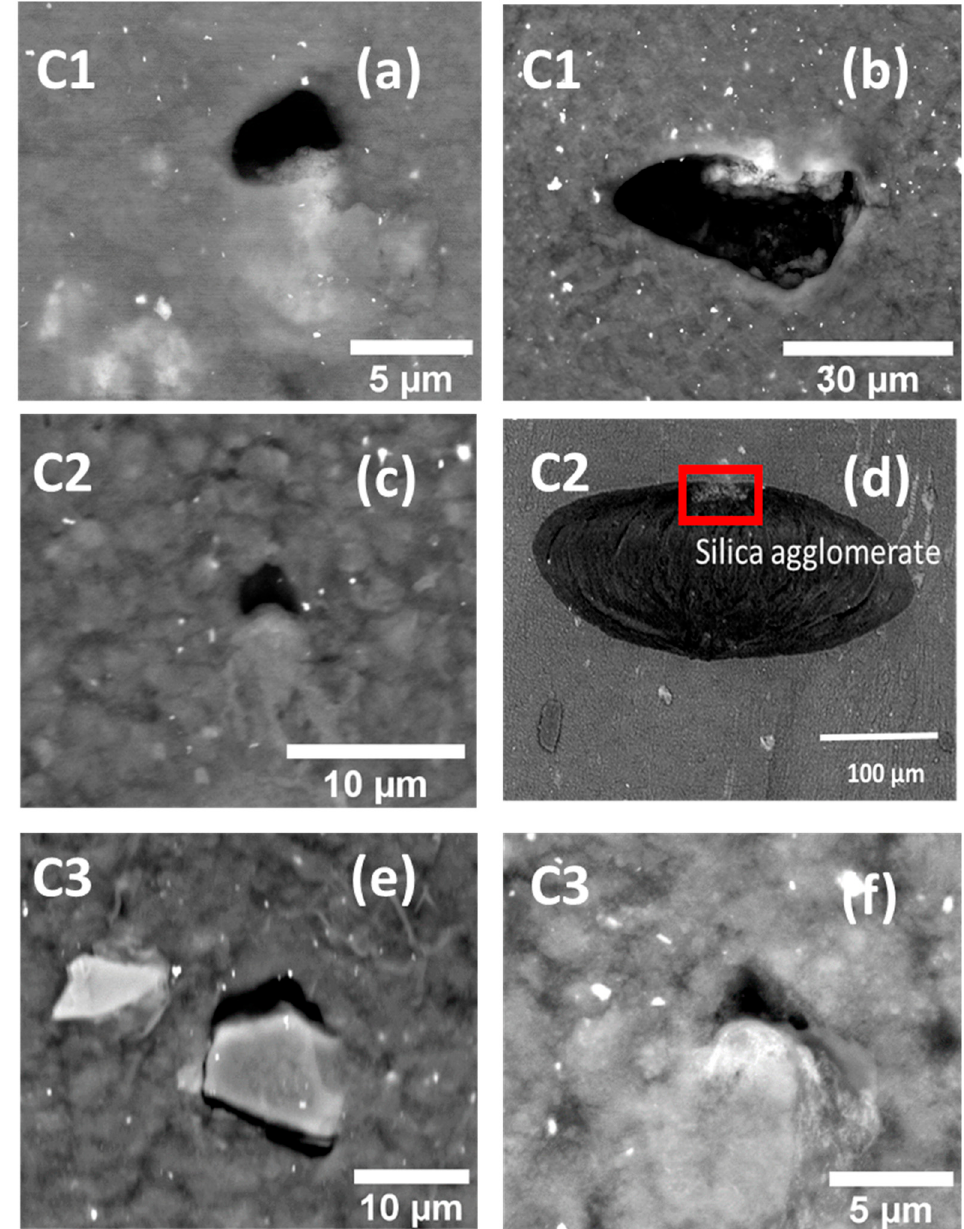
Figure 7. SEM backscattered electron imaging of interrupted fatigue sample surface showing debonding at one pole and at both poles for various compounds at stage 1 ( a , c , e , f ), stage 2 ( b ) and stage 3 ( d ) respectively (samples subjected to 200% of local strain and 40% of N i , loading direction is vertical).